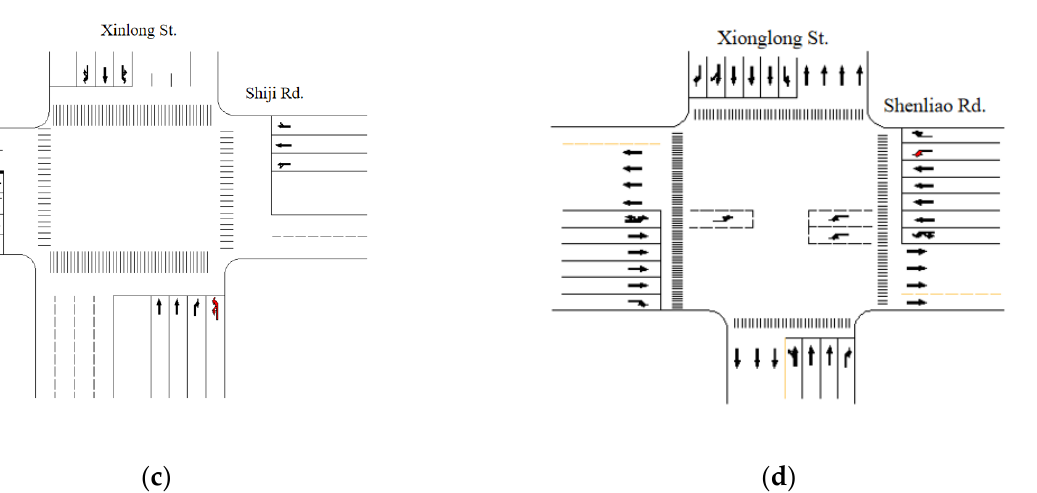
Figure 1. Road conditions at the four intersections. ( a ) The intersection of Southwest Rd. and Nansha St. (inside). ( b ) The intersection of Southwest Rd.and Huanghe Rd. (inside). ( c ) The intersection of Xinggong St. and Shenliao Rd. (outside). ( d ) The intersection of Xinlong St. and Shiji Rd. (outside).